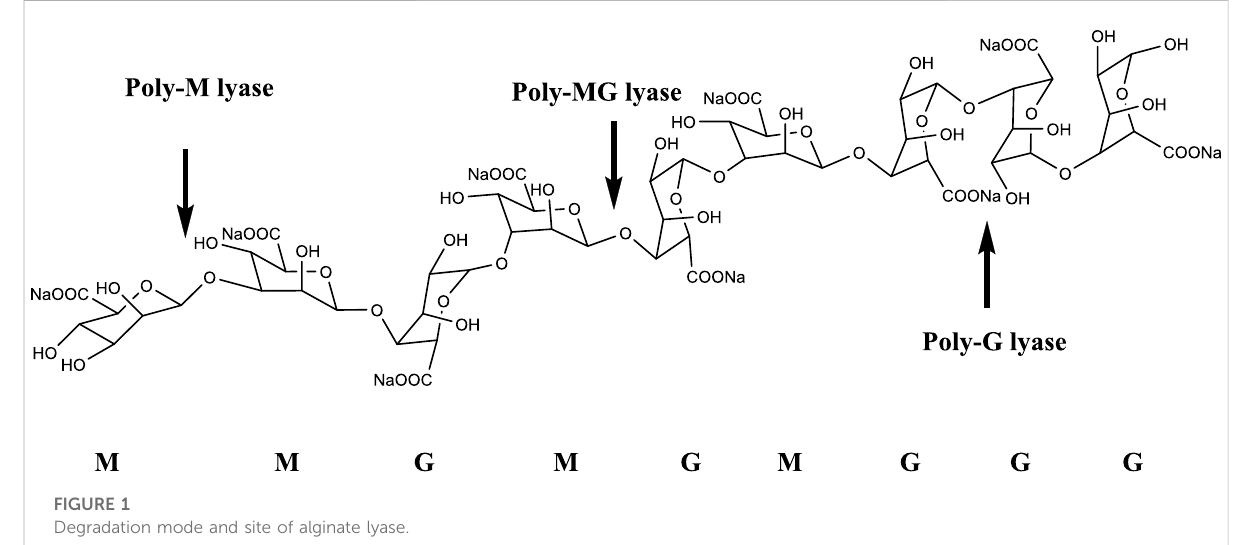
FIGURE 1 Degradation mode and site of alginate